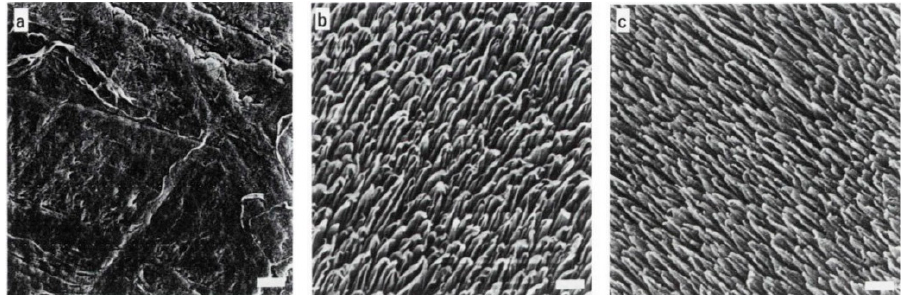
Figure 5. Light microscopy images of human skin fibroblasts attached to tissue culture-treated polystyrene (TCPS) ( a ), untreated FEP–Teflon ( b ), and hydrophobized FEP–Teflon ( c ). The bar denotes 37 μ m. Reprinted from reference [93].